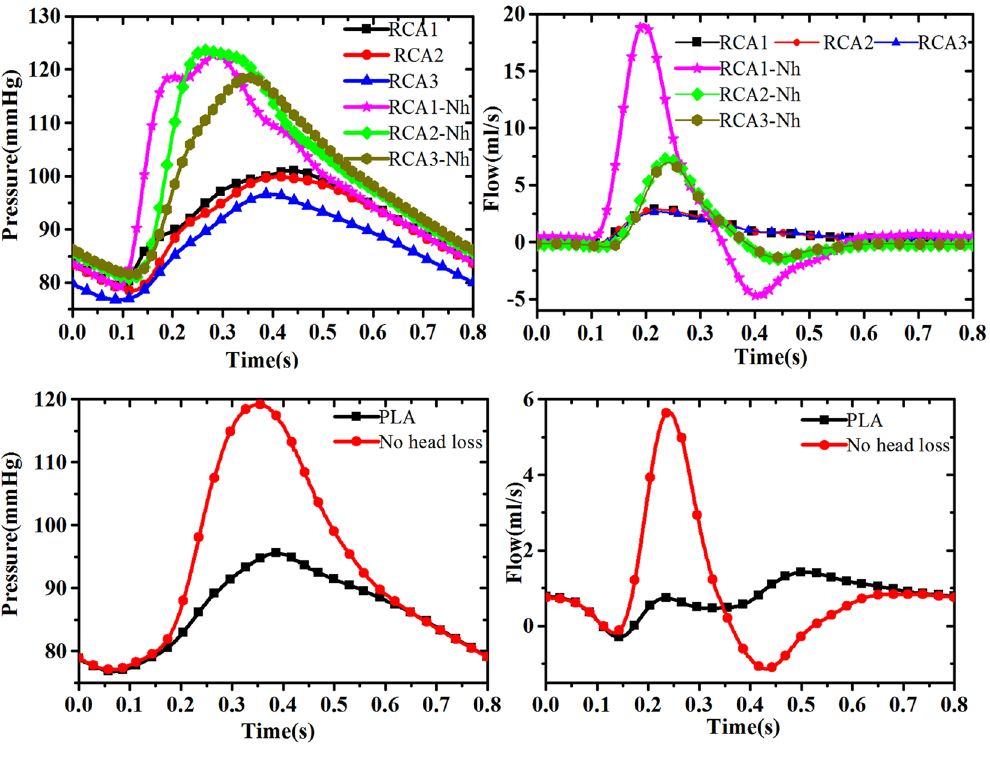
Figure 3. The pressure and flow rate waveforms, with or without head loss, along the RCA segments (top), where Nh in RCA stands for no head loss, and along the PLA (bottom).